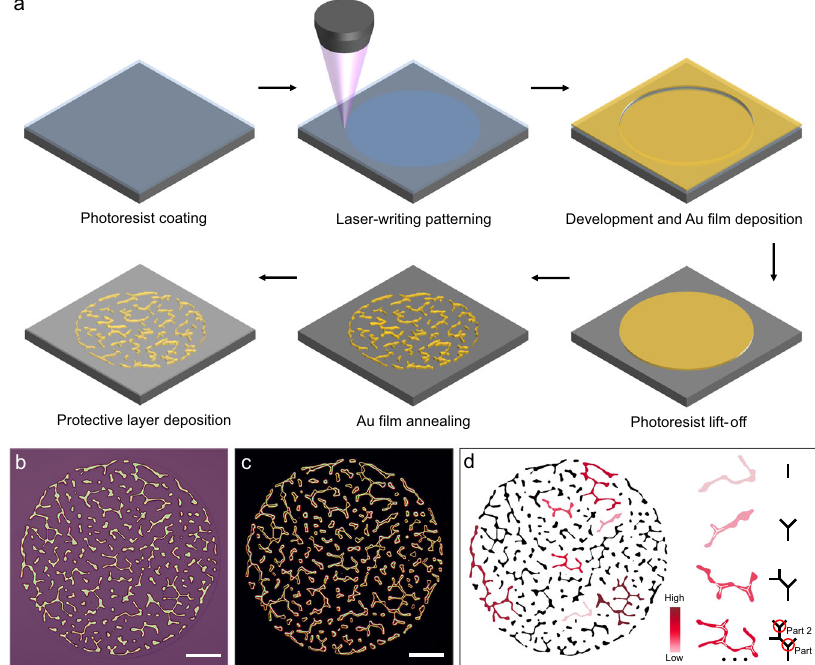
Fig. 1 | Fabricationand characterizationofrandomfractal-guidedPUFs. a Flow chartofthePUFtagfabrication.TheSi/SiO 2 substratewas fi rstspin-coatedwithone layer of photoresist (step 1), followed by laser-writing the circular fi lms as basic units(step2).Afterthedevelopmentofthepatterningarea,onelayerofAu fi lmwas then deposited on the substrate through magnetron sputtering (step 3), followed by the photoresist lift-off procedure (step 4). Next, the Au fi lm in the circular area was annealed to obtain the random fractal-like Au networks (step 5). Finally, one layeroftheopticallytransparentthin fi lmwasspin-coatedonthetagasaprotective